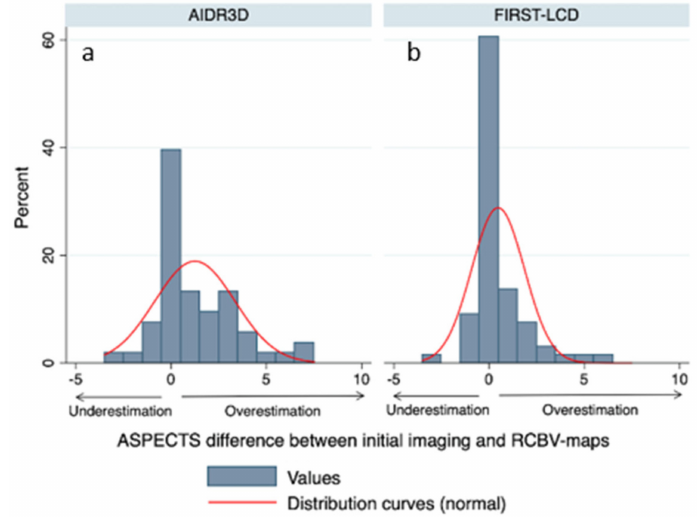
Figure 2. ASPECTS difference between initial FIRST-LCD ( b ) and AIDR3D ( a ) and rCBV-map (rCBV ASPECTS). The narrower the distribution curve, the higher the distribution curve near 0, and the smaller the difference in ASPECT scoring between a reconstruction technique (FIRST-LCD or AIDR3D) and rCBV ASPECTS. FIRST-LCD ASPECTS ( b ) more closely match the rCBV ASPECTS than AIDR3D ASPECTS ( a ).